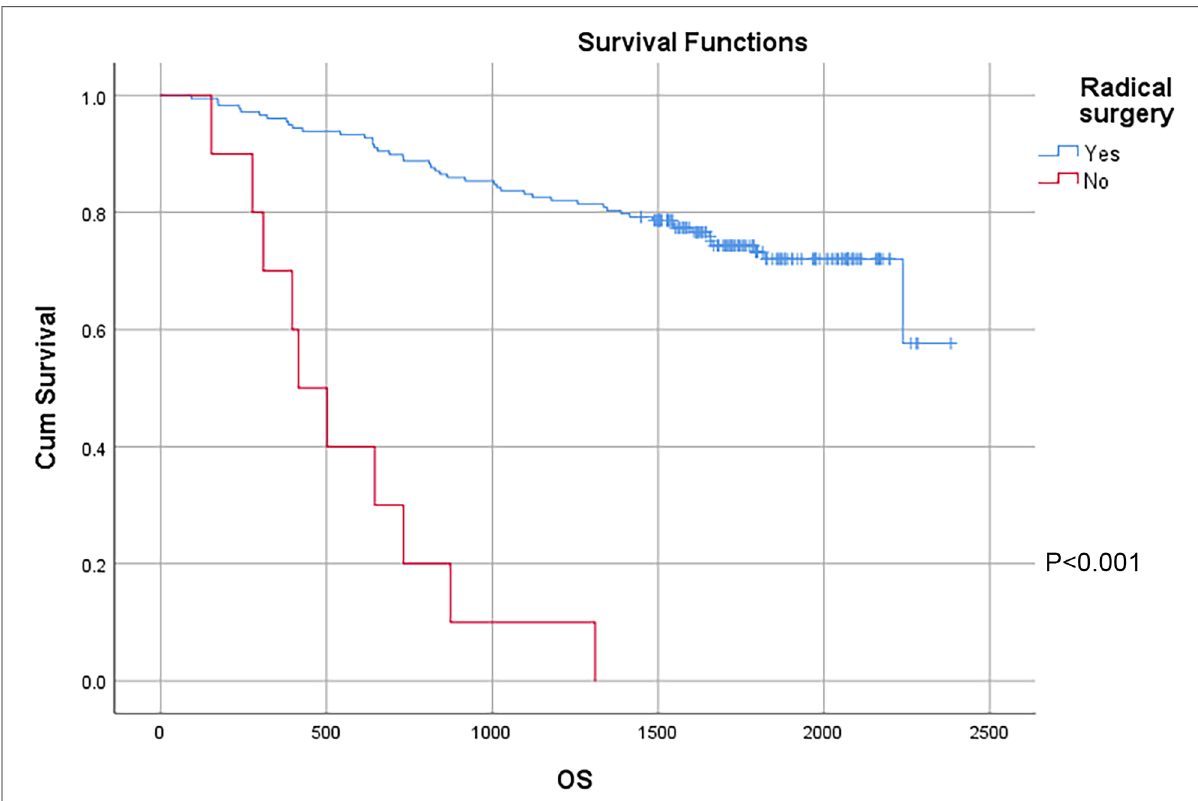
FIGURE 1 Survival curves of colon cancer patients in different radical surgery